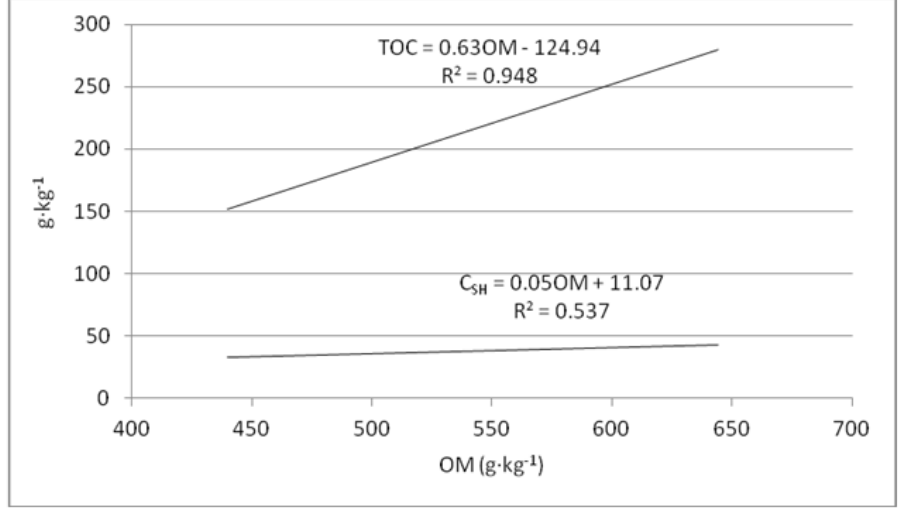
Figure 5. Linear regression for organic matter (OM) and humic substance (C SH ) and total organic carbon (TOC) in vermicomposts.